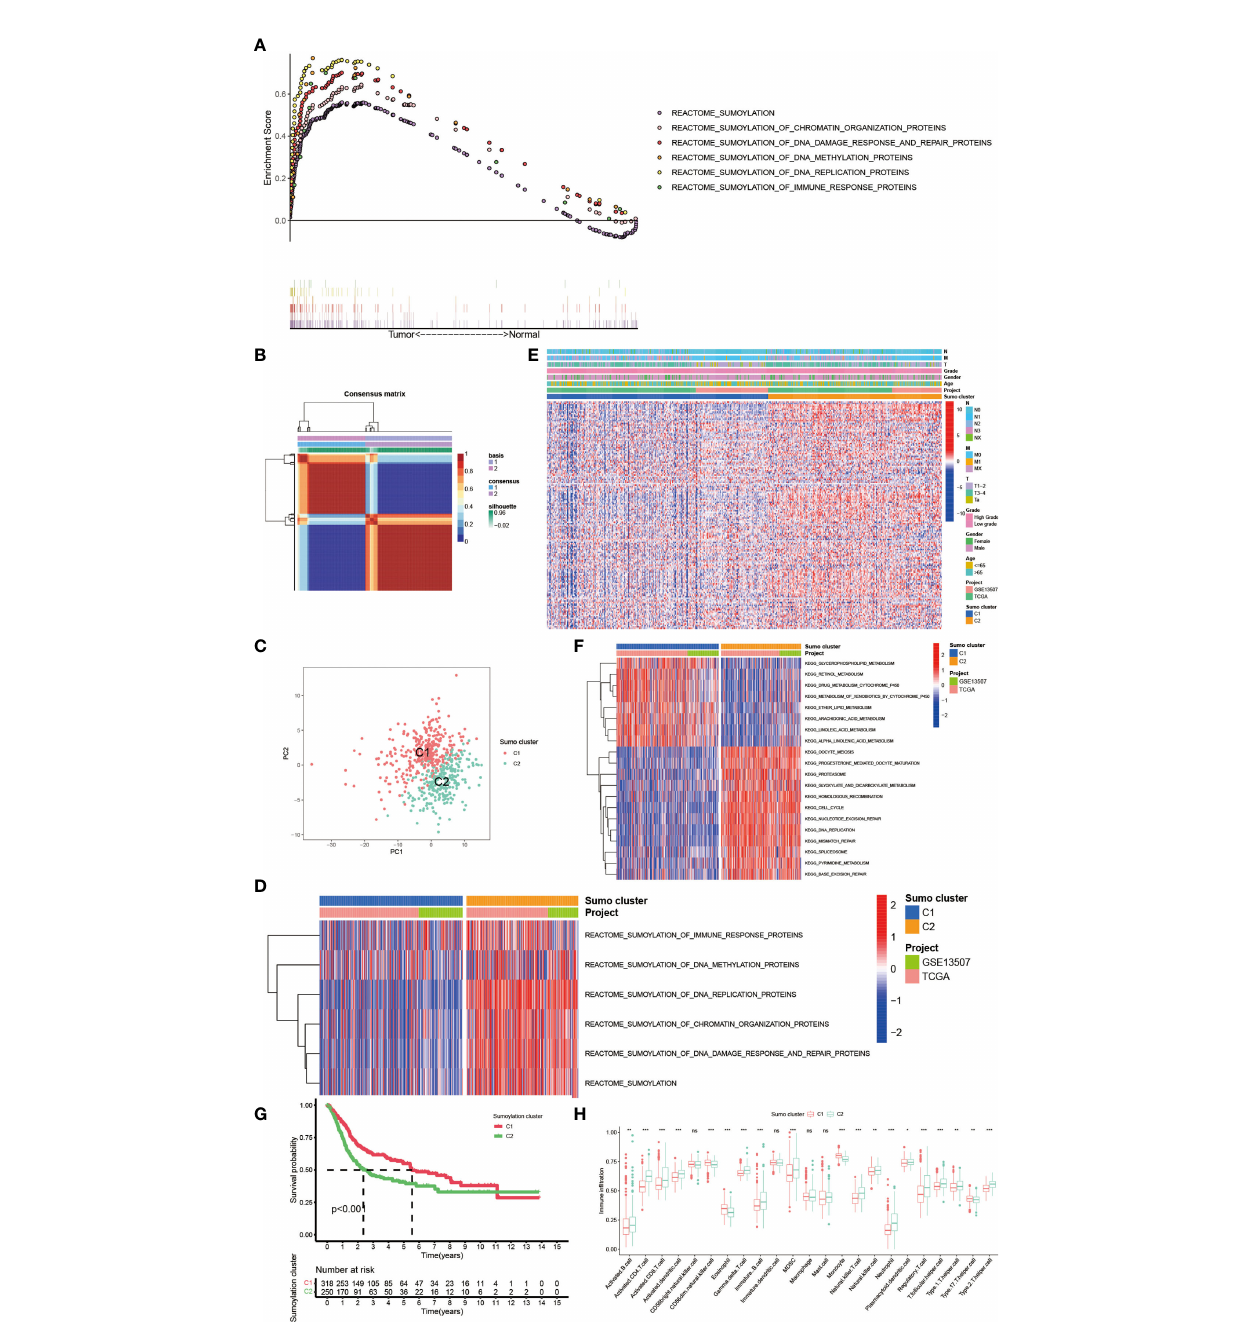
FIGURE 2 | The generation of SUMOylation patterns and clinical and biological characteristics, hallmark pathways, and TME cell in fi ltration characteristics in distinct SUMOylation patterns. (A) The enrichment score of genes involved in SUMOylation and SUMOylation related biological processes between tumor and normal adjacent tumor tissue. (B) Connectivity matrix for patients with bladder cancer in the meta-cohort by NMF when k = 2. (C) Principal component analysis for the transcriptome pro fi les of two SUMOylation patterns, showing a remarkable difference on transcriptome between different SUMOylation patterns. (D) Transcriptome pro fi les of genes involved in SUMOylation and SUMOylation related biological processes between the two distinct SUMOylation patterns. (E) Heat map for the relationship between clinical characteristics and SUMOylation patterns. (F) GSVA enrichment analysis showing the activation states of biological pathways in distinct SUMOylation patterns. The heatmap was used to visualize these biological processes, and red represented activated pathways and blue represented inhibited pathways. The project and Sumo cluster were used as sample annotations. (G) Kaplan – Meier curves indicated SUMOylation patterns were markedly related to overall survival of 568 patients in meta- cohort, of which 318 cases were in SUMO cluster C1 and 250 cases in SUMO cluster C2 (P <0.001, Log-rank test). (H) The abundance of each TME in fi ltrating cell in two SUMOylation patterns. The upper and lower ends of the boxes represented interquartile range of values. The lines in the boxes represented median value, and black dots showed outliers. The asterisks represented the statistical p-value (ns, no signi fi cance; *P < 0.05; **P < 0.01; ***P <